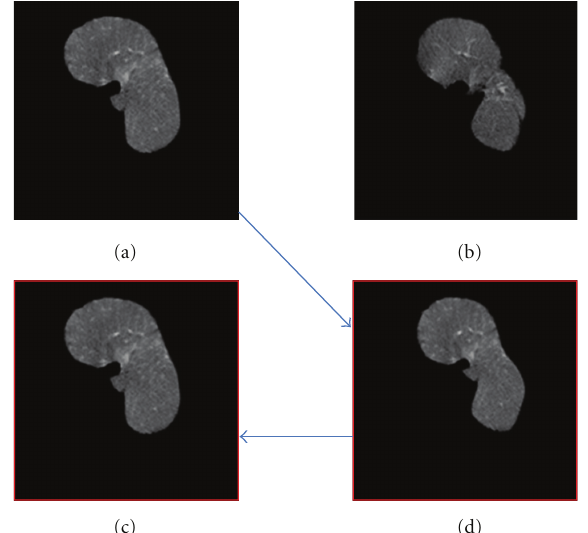
Figure 5: 3D shape normalization processing (one slice from volume data). (a) Moved image. (b) Fixed image. (c) Shape normalized moved image. (d) Inverse of 3D shape